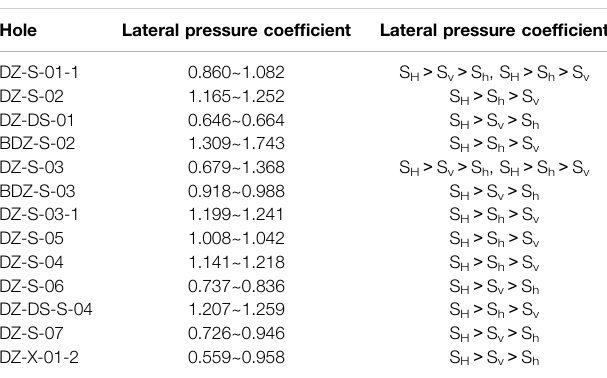
TABLE 2 | Lateral pressure coef fi cients of different